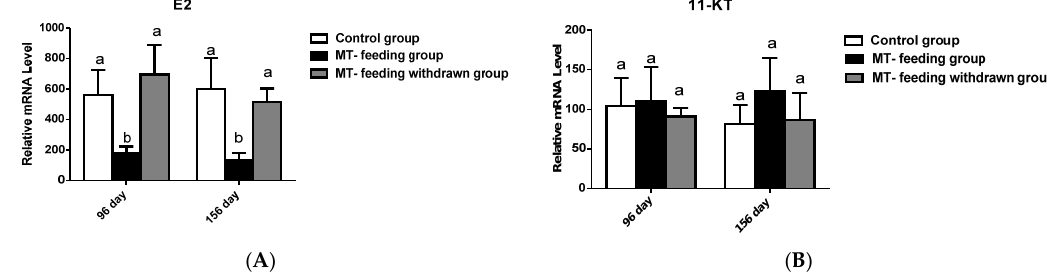
Figure 8. Serum E2 and 11-KT level after MT-feeding withdrawal. ( A ) The E2 level in the control, MT-feeding and MT-feeding withdrawn groups. ( B ) The 11-KT level in the control, MT-feeding, and MT-feeding withdrawn groups. Data are expressed as the mean ± SD for five fish. Different letters indicate significant values at p < 0.05.